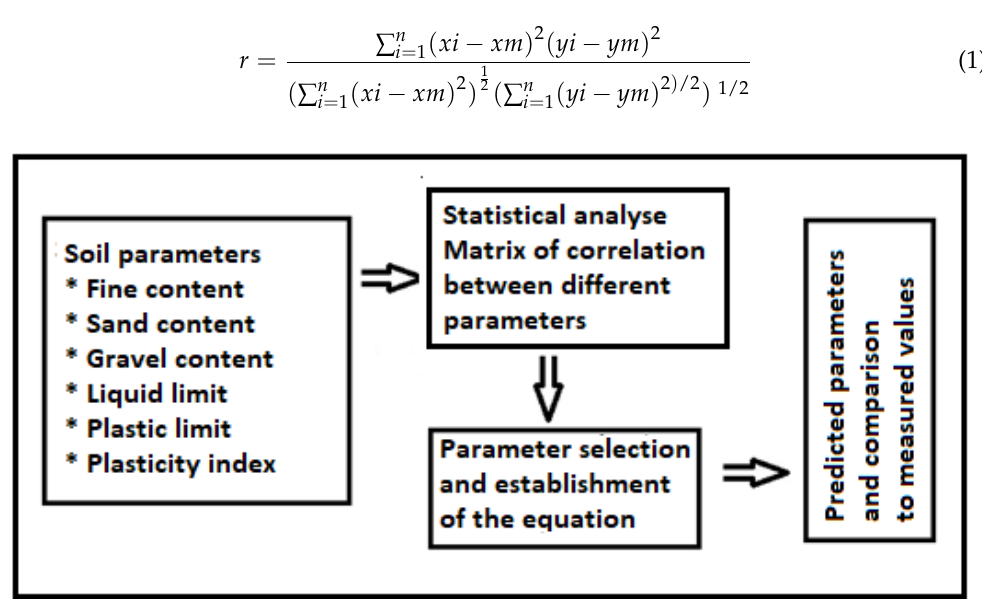
Figure 1. Steps to determine the proposed equation used in the prediction of the γ dmax and w Opt .